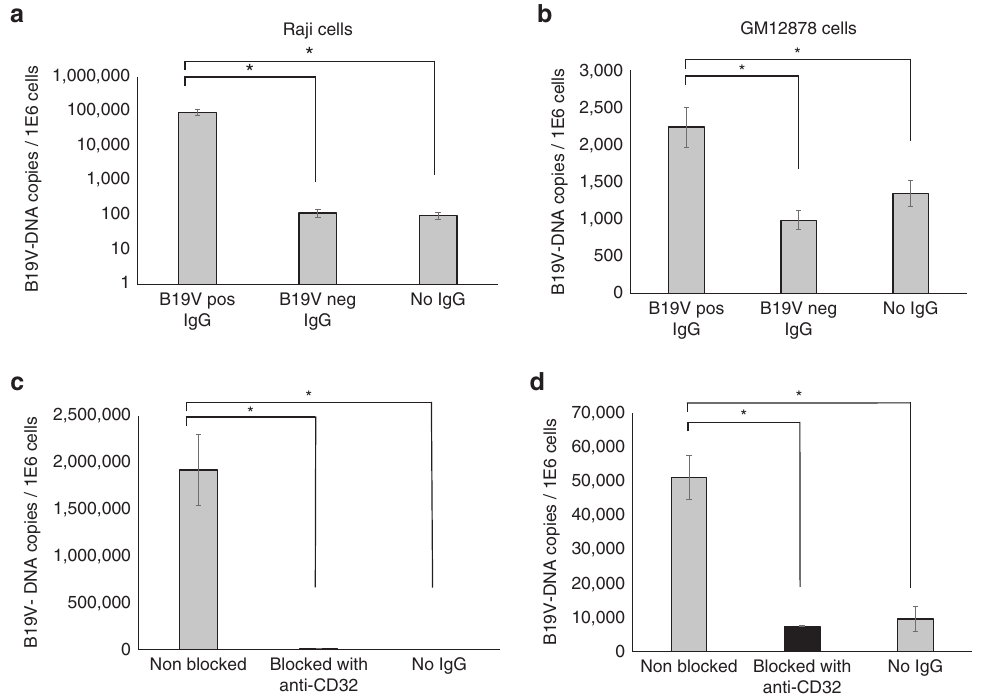
Figure 5 | Antibody-dependent uptake of native B19V in B cell lines. ADE was tested using viremic plasma in Raji (left column) and GM12878 (right column) cells in the presence of total purified B19V-positive or -negative IgGs ( a , b ). The effect on viral uptake was evaluated before (grey bars) and after (black bars) blocking with an anti-CD32 antibody ( c , d ). Error bars represent s.d. (of three replicates). *Represents statistical significance ( P o 0.001) between positive and respective negative controls, as calculated by Student’s t